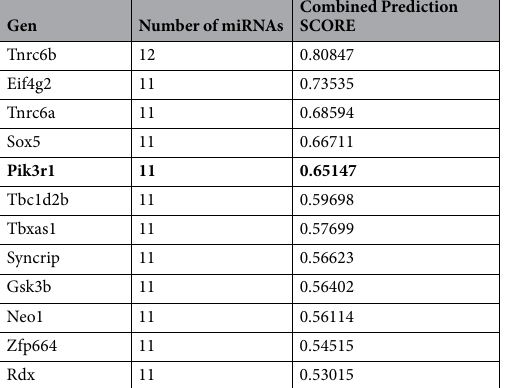
Table 1. Targets of upregulated miRNAs in CD4 T cell activation. Prediction of the targets of the miRNAs upregulated in CD4 T cells from OT-II mice after stimulation with cDCs loaded with OVA peptide. Prediction was performed with a combinatorial method of different available prediction tools. Higher combined prediction score denotes more confidence in the prediction.